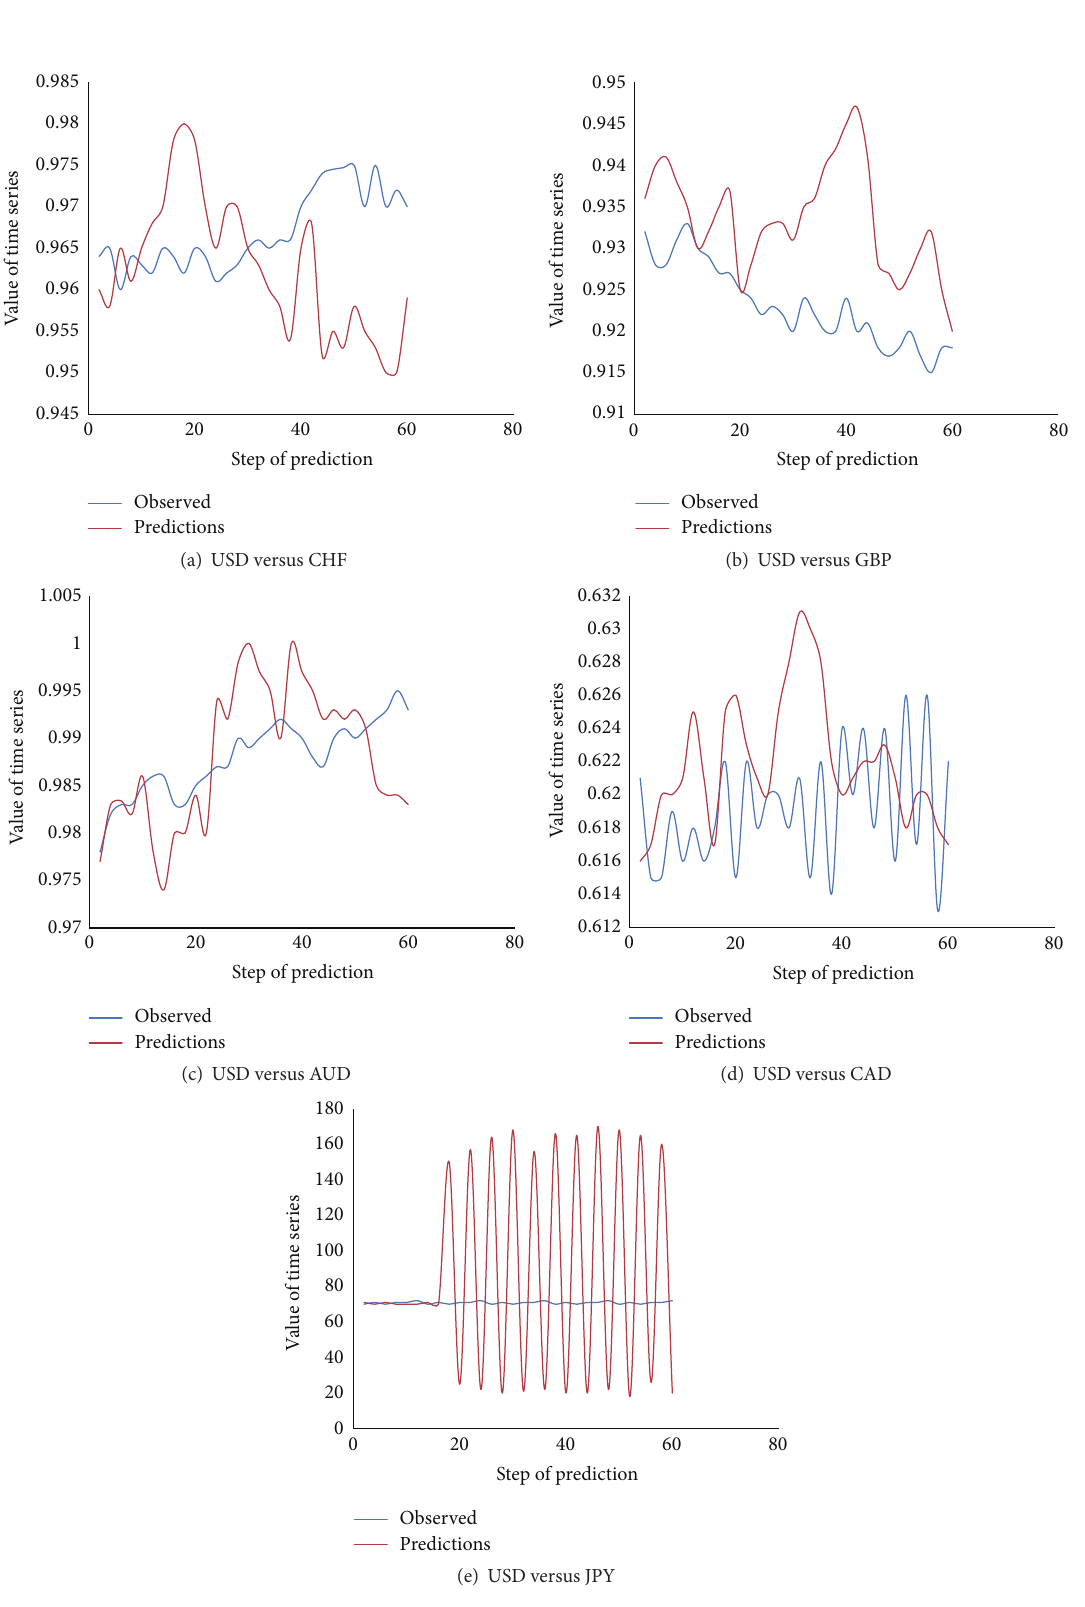
Figure 6: Implementation results of